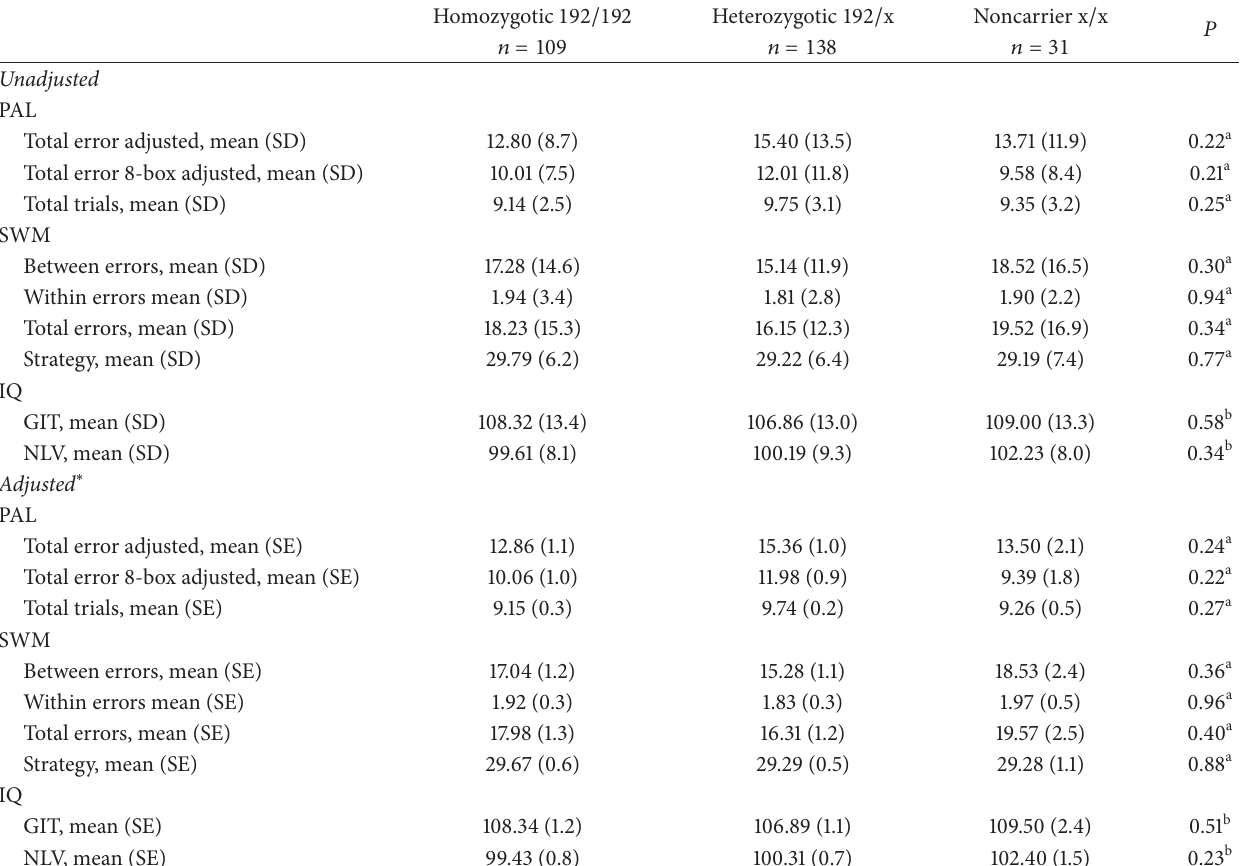
Table 2: Mean unadjusted and adjusted ∗ scores on cognitive measures per genotype of IGF-1 promoter region ( 𝑁 = 278